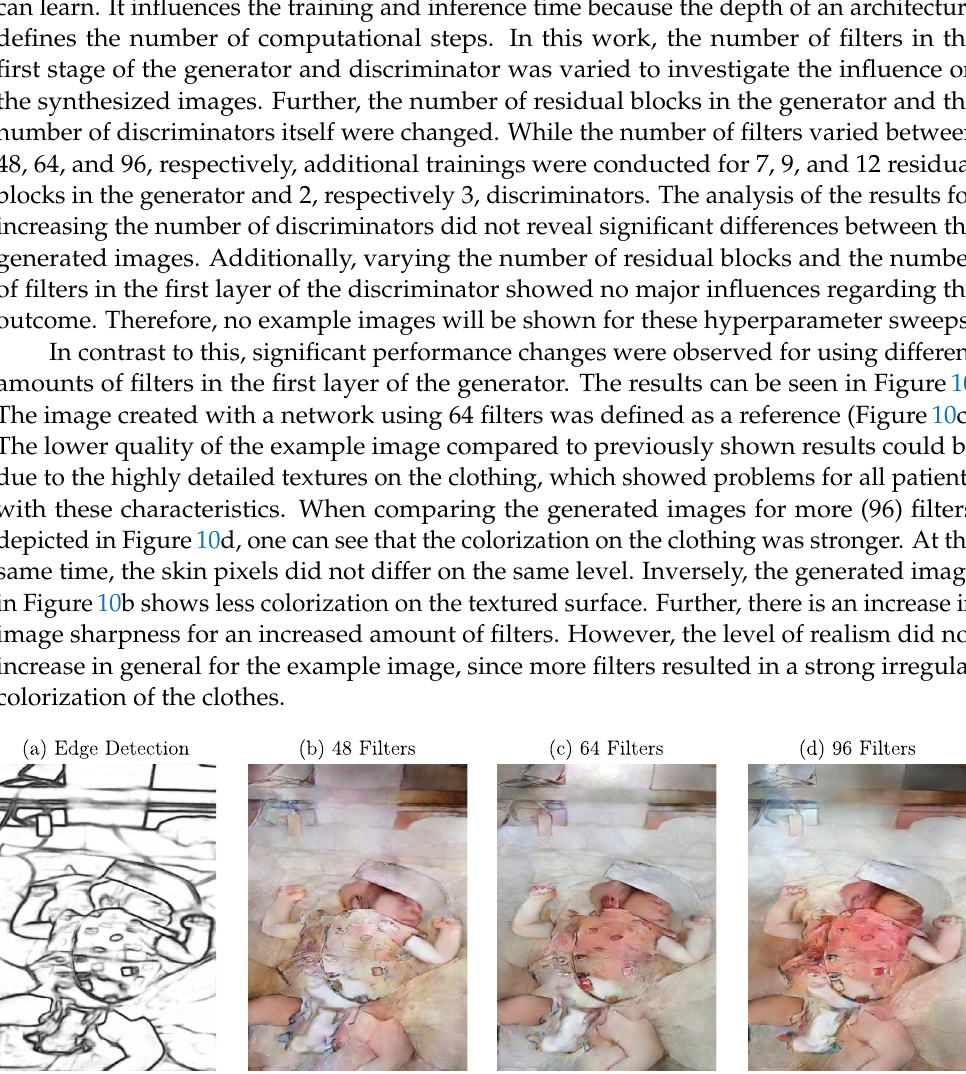
Figure 10. ( a ) Example edge detection image with resulting images after training with ( b ) 48, ( c ) 64, and ( d ) 96 filters in the first convolution stage of the